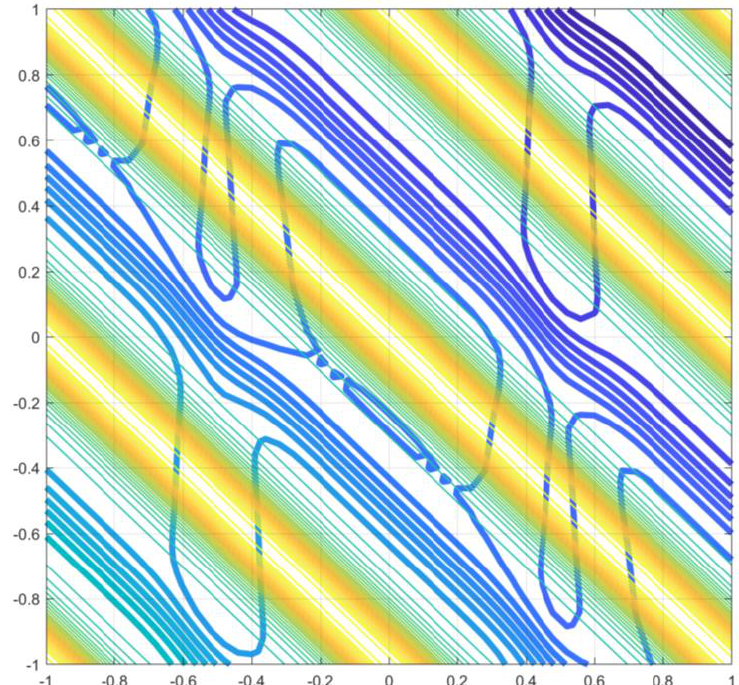
Figure 7. Quasi-analytical hydraulic head field h ( x , y ) given in the text, shown as bold contours. The contours of periodic permeability K ( x , y ) with σ LnK = Ln 10 ≈ 2.30 are also superimposed as thin curves. The broad white bands of K ( x , y ) correspond to zones of minimal permeability, coinciding also with zones of large head